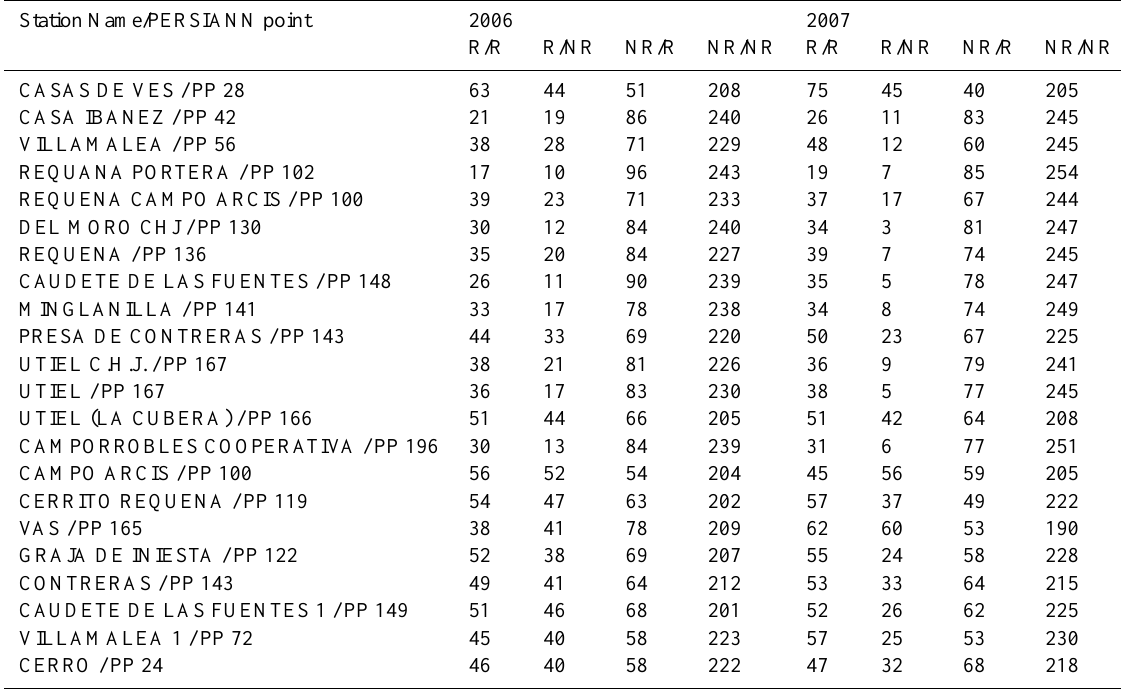
Table 2. Contingency table illustrating the number of rain events measured by the satellite but not measured by the rain gauges and vice versa (R stands for “rain” and NR stands for “non rain”). The comparison was done between all the meteorological stations/ rain gauges and their nearest PERSIANN points available over the VAS area for 2006 and 2007.